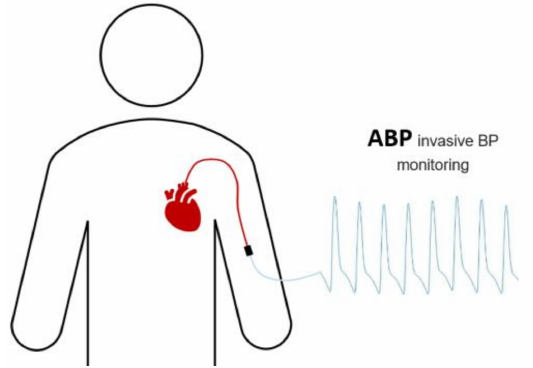
Figure 1. ABP signal recorded invasively.